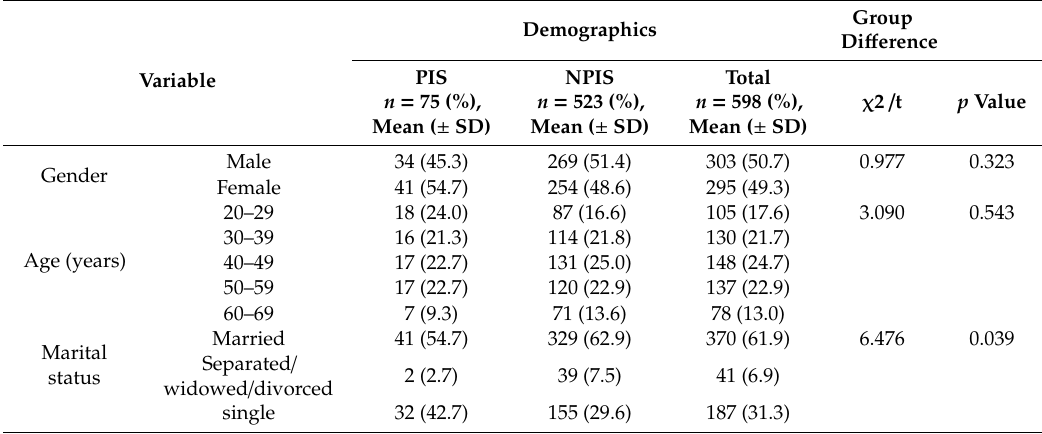
Table 1. Comparison of online shopper with and without problematic shopping behavior.